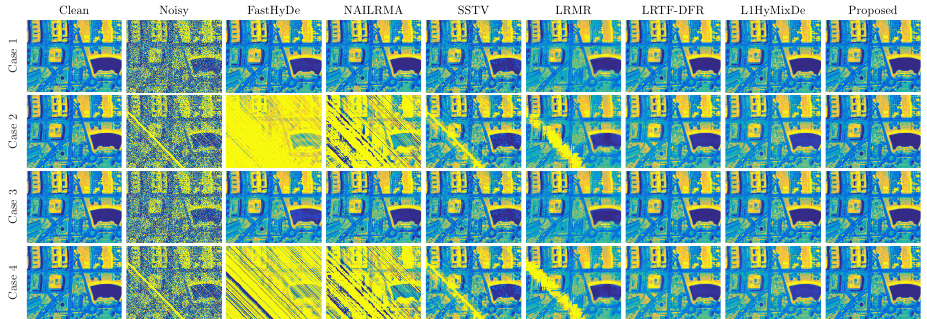
Figure 7. Band 126 of the Washington DC Mall data before and after denoising in four cases.